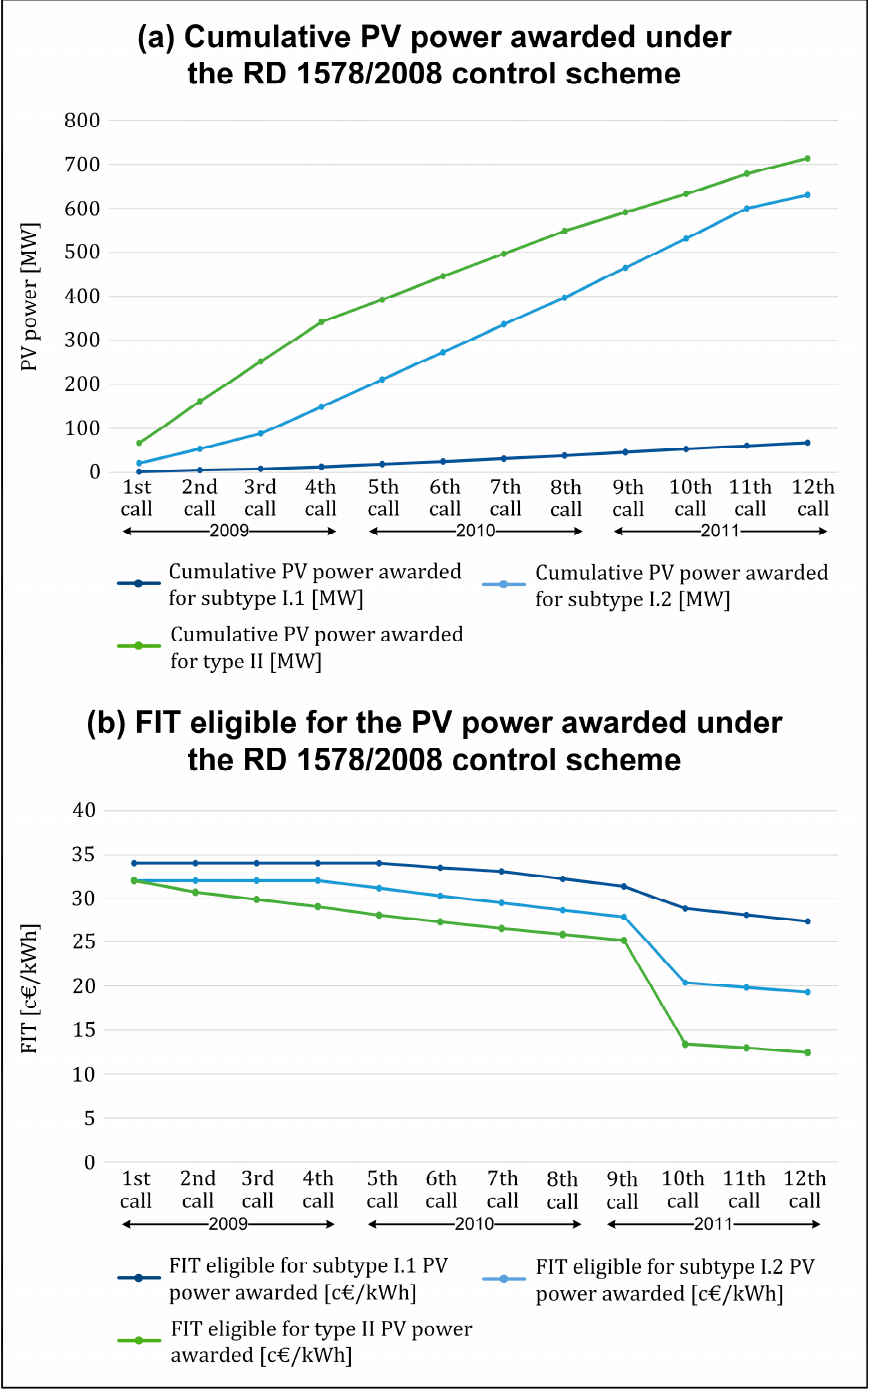
Figure 7. Evolution of the solar PV technology under RD 1578/2008 control structure during the period 2009–2011 in terms of: ( a ) the cumulative PV power awarded; ( b ) the FIT eligible for the PV power awarded. Source: self-elaboration based on [69].